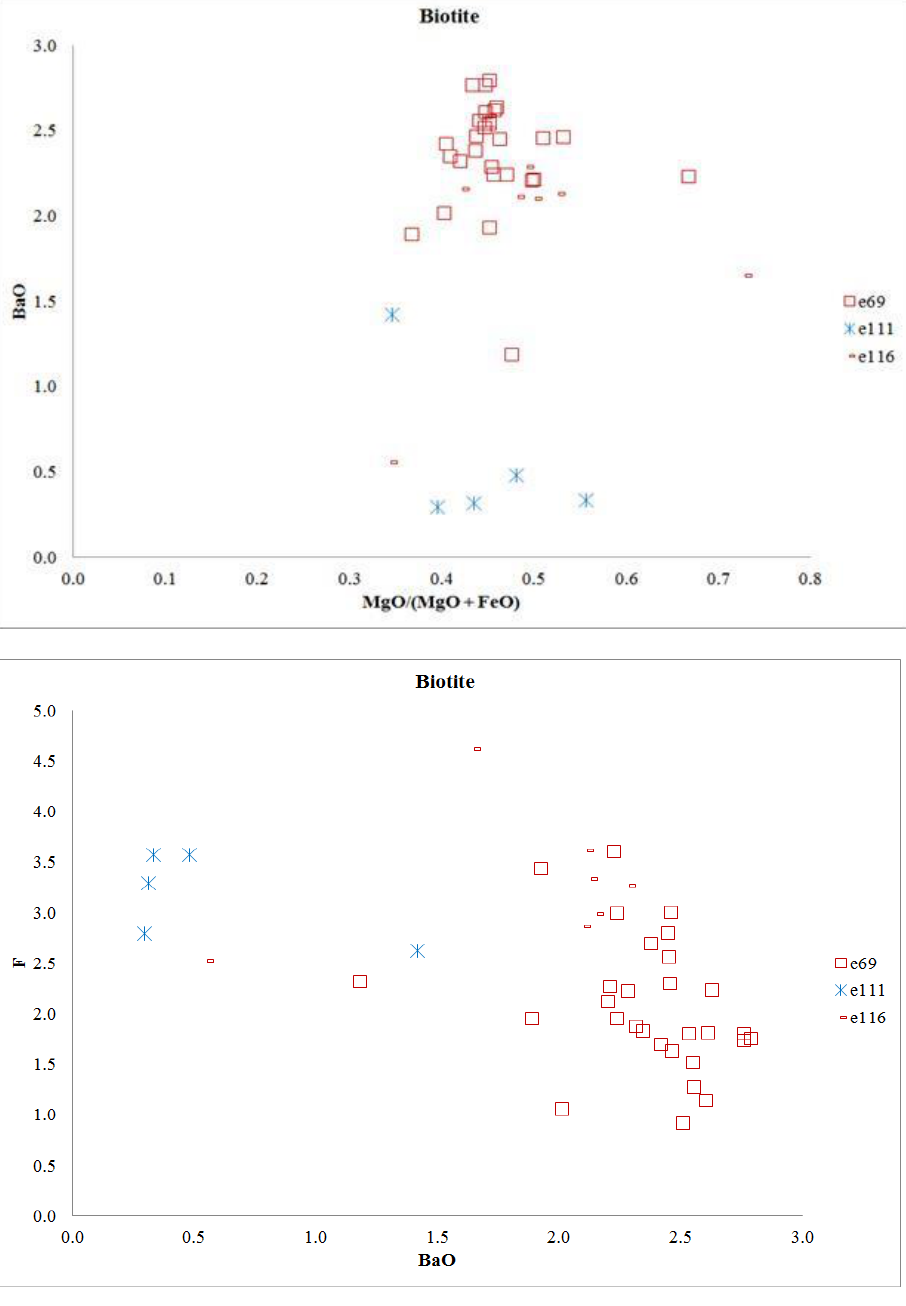
Figure 7. Biotite chemical plots show the changes in mineral chemistry. Biotite contains high BaO and F as well as high TiO 2 (Table 3).